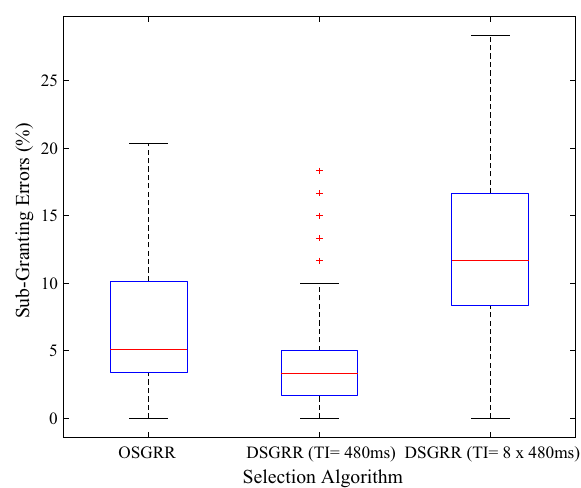
Fig. 16 Sub‑granting errors comparison between the DSGRR and OSGRR algorithms